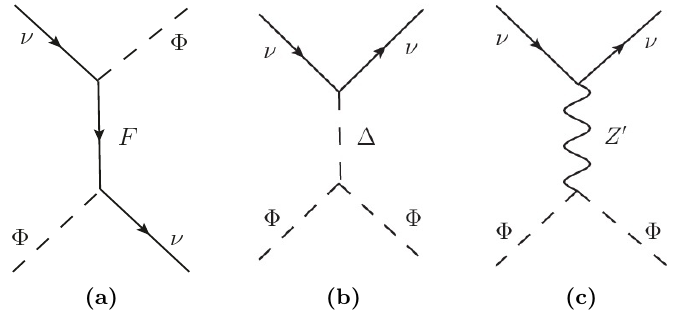
Figure 4. Renormalisable cases of neutrino-DM scattering with (a) fermion, (b) scalar and (c) vector